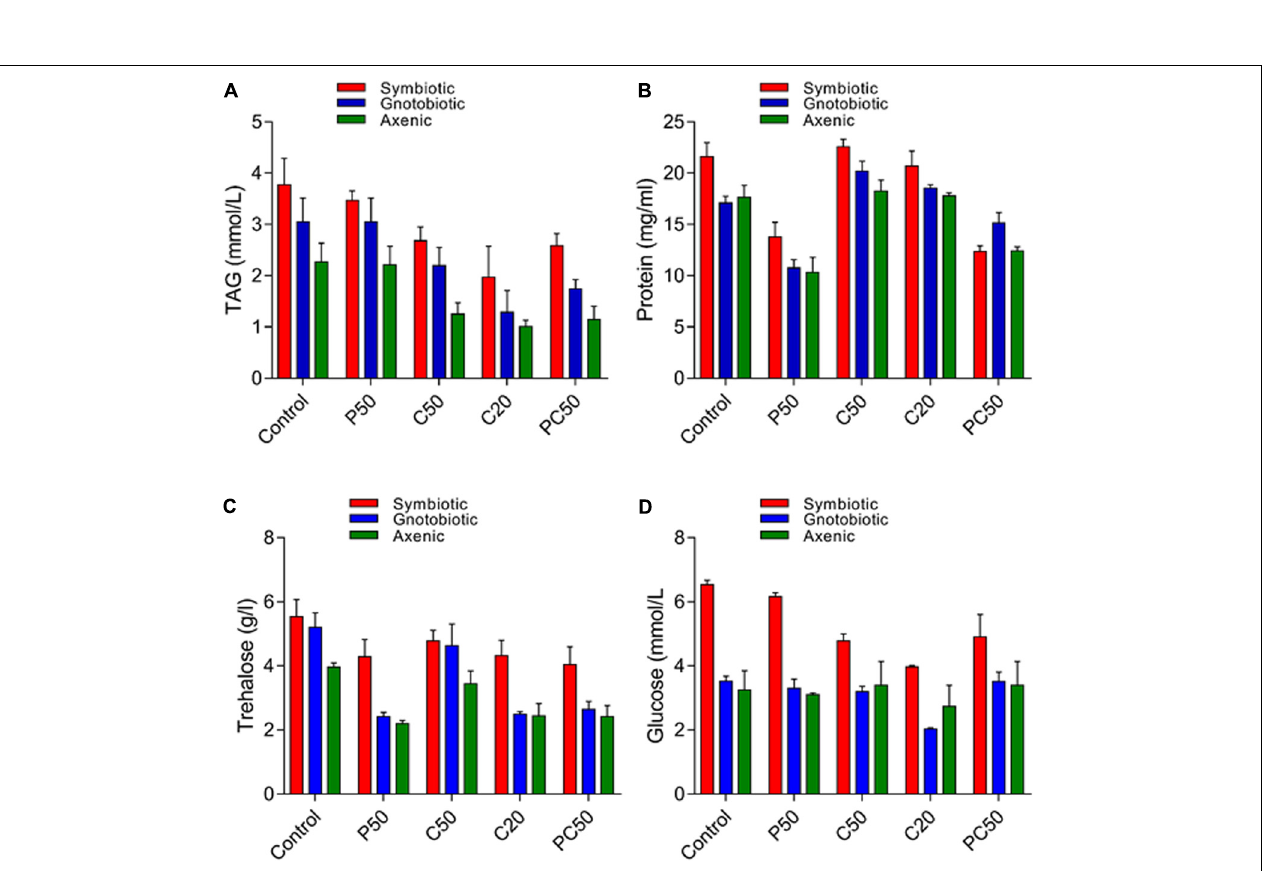
FIGURE 4 | Nutritional indices in the hemolymph of B. dorsalis larvae feeding on different diets after bacterial manipulation: TAG (A) , protein (B) , trehalose (C) , and glucose (D) .